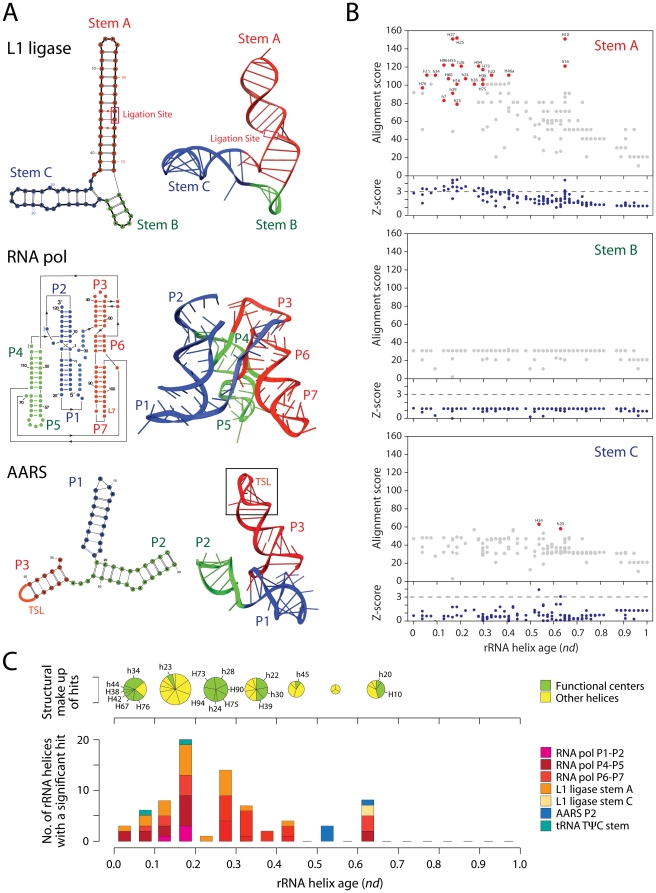
Similarity of ancestral rRNA structures to in vitro evolved ribozymes.
A, Models of secondary and tertiary structure of L1 RNA ligase, RNA polymerase, and aminoacyl-tRNA synthetase (AARS) ribozymes. The long helix (stem A) of the 3-stemmed L1 RNA ligase molecule harbors the catalytic site and the junction of the three helical regions P1–P2, P4–P5 and P6–P7 at the center of the tripod-like RNA polymerase structure is the catalytic center. B, Alignment scores (top panels) and Z-score tests of statistical significance (bottom panels) for individual alignments of L1 ligase and rRNA helices of different age. Z-scores were derived from the alignment of 1,000 randomized sequences. Alignment scores of structures with Z-scores over 3 (horizontal dashed line) are significant at 0.01% confidence levels and are colored in red. C, Structural make up (pie charts) and frequency (bars) of rRNA helices of different age sharing structural features with the ribozymes. Only helices associated with functional centers (green pies) are labeled.